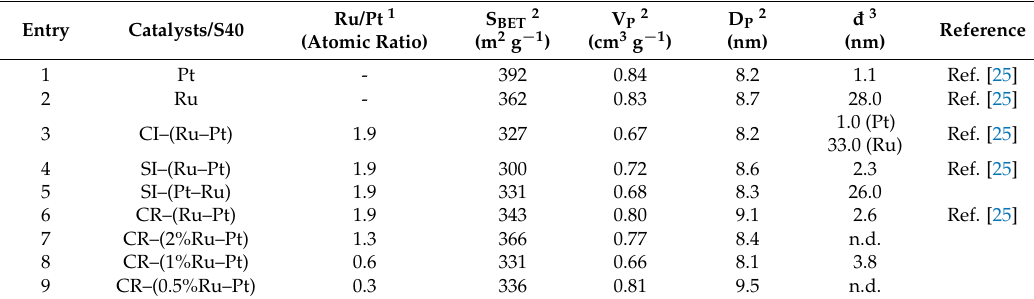
1 Calculated from the metallic weight contents determined from elemental analysis. 2 Specific surface area S pore volume V P and pore diameter D P determined by N 2 sorption measurements. Values for the lone S40 support: